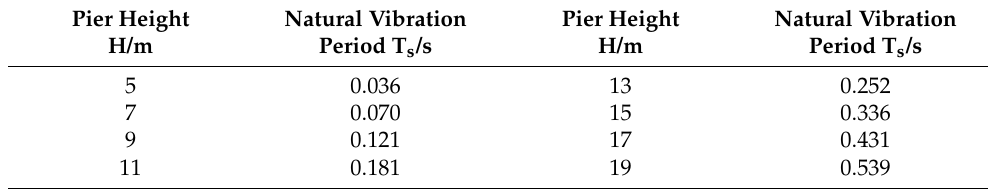
Table 2. Longitudinal natural frequency of the bridge at different heights.